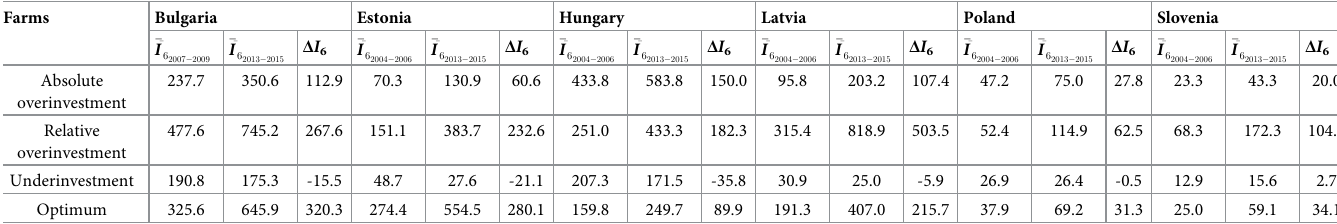
Table 7. Production value (EUR thousand per farm) in farms grouped by scale of investment in 2007–2009 and 2013–2015 ( I